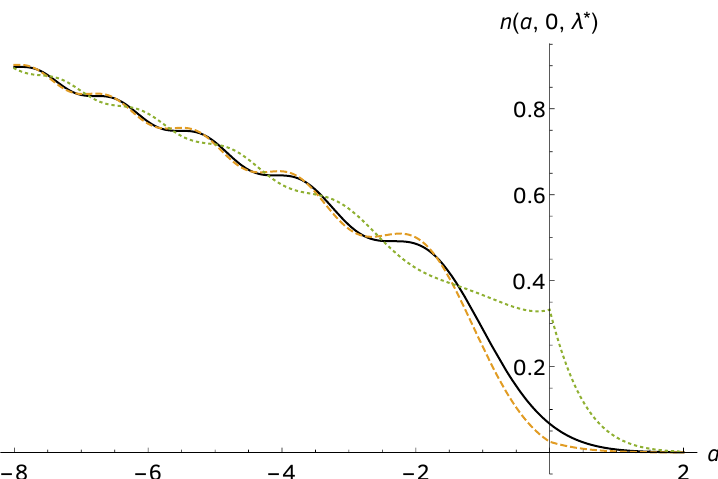
Figure 7: The rescaled density n ( a ,0, λ ∗ ) as a function of the rescaled distance a , for a delta function interaction placed at the edge of a trap c = 0 on top of a potential which is locally linear at the edge. In black solid is the case where λ ∗ = 0, that is to say no perturbation. In dashed is shown the case where λ ∗ = 1 (repulsive impurity) while the case λ = − 1 (attractive impurity) is shown by the dotted